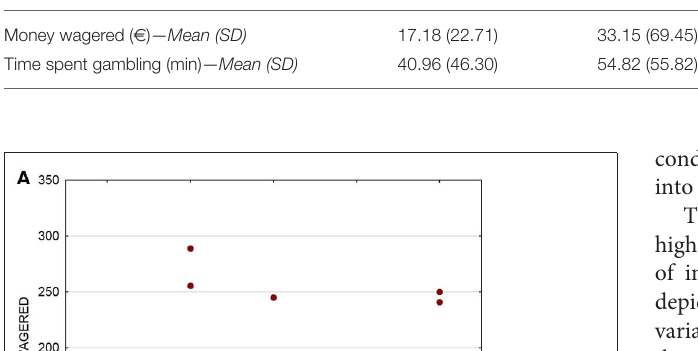
Table 3 describes the two main outcomes (money wagered and time spent gambling during the gambling session) according